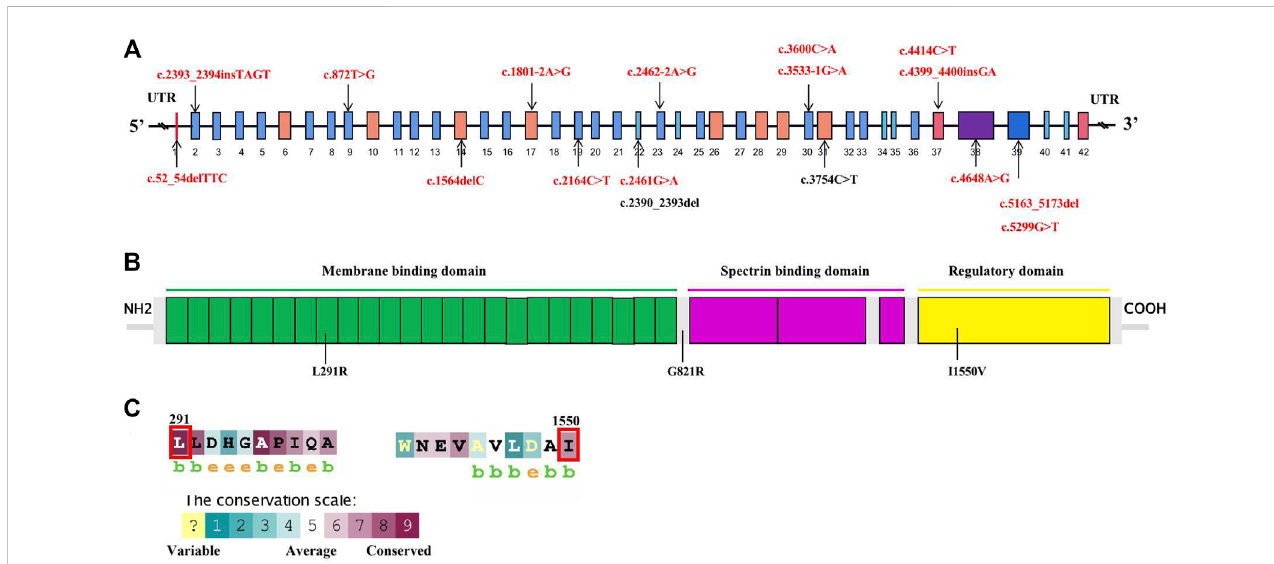
FIGURE 2 Schematic diagram of mutations of the ANK1 gene and conversation of amino acid residues affected by the missense mutations. (A) Mutations in the genome of ANK1. Fifteen novel mutations, and previously reported ones are highlighted in red bold and black bold, respectively. (B) The human erythroid ankyrin protein consists of an N-terminal membrane protein binding domain composed of ankyrin repeats (green box), a central spectrin-binding domain (violetbox),andaC-terminalregulatorydomain(yellowbox).Threemissensemutationsarelisted. (C) Theevolutionary-conservationscoresforresidues encompassing the missense mutations in the ANK1 protein, re fl ecting the full alignment of 62 ANK1 homologues from different species, including mammals, lowervertebrates,invertebrates,andlowereukaryotes,asobtainedfromtheUniRef90database.Thesubstitutedresidues,whichareoutlinedbytheredboxin (C) , are highly conserved.